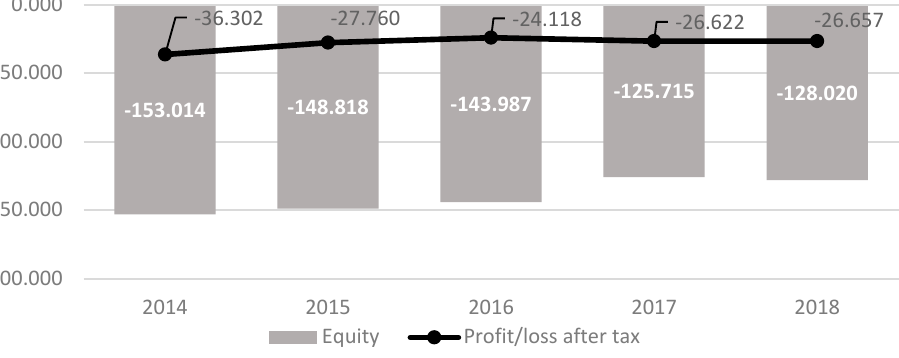
Figure 4. Development of the average amount of a negative equity and profit or loss after tax.